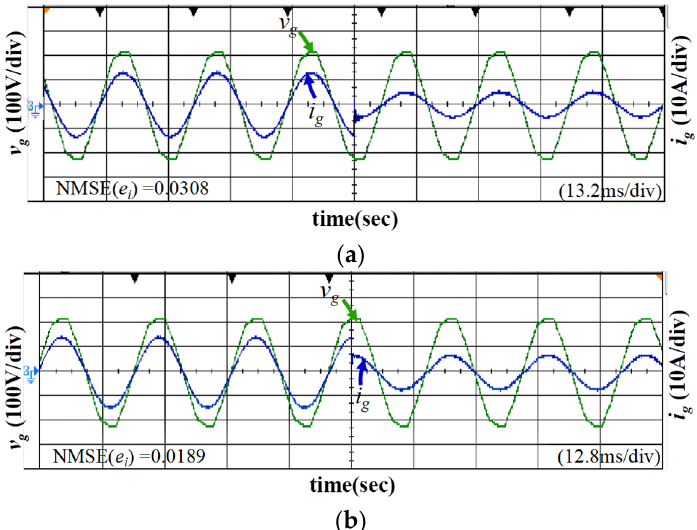
Figure 9. Experimental voltage and current response of grid-connected inverter under grid-con- nected power variations from 1 kW to 0.5 kW: ( a ) GISMC; ( b ) DRFNNISMC.